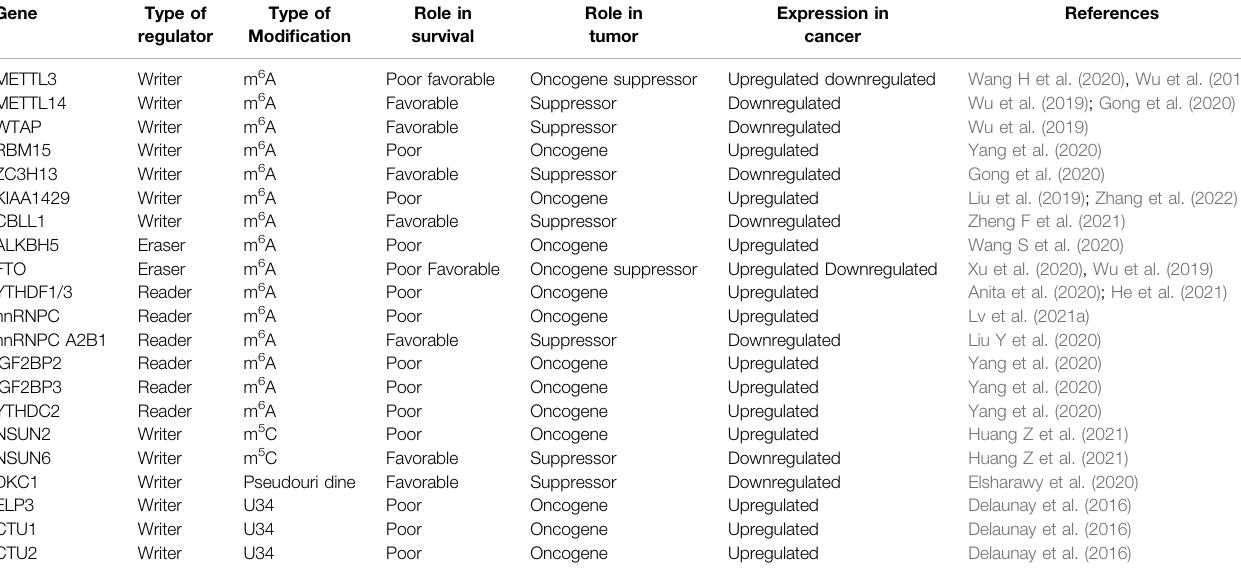
TABLE 1 | The main role of regulators of RNA modi fi cation related with prognosis of breast cancer.